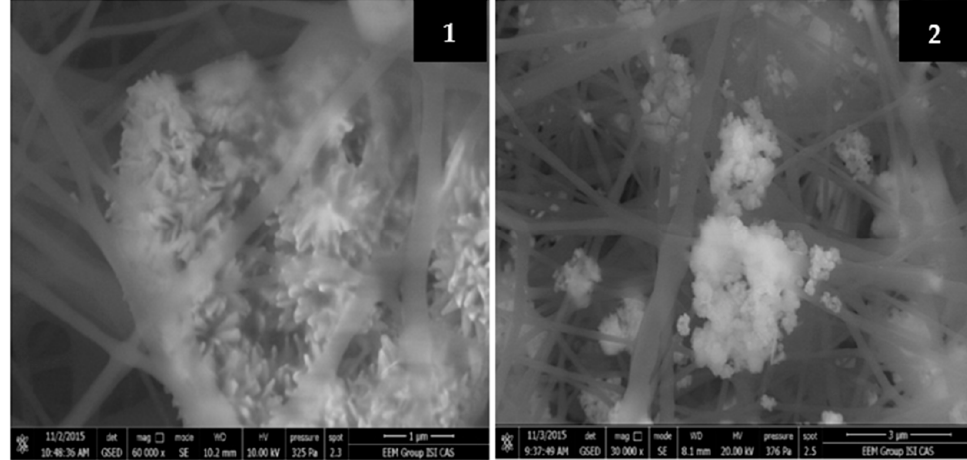
Figure 5. SEM images of PU nanofibres with 7% ( 1 ) and 12% ( 2 ) of CuO NPs produced from rotating electrode with a needle surface (60,000x magnification).